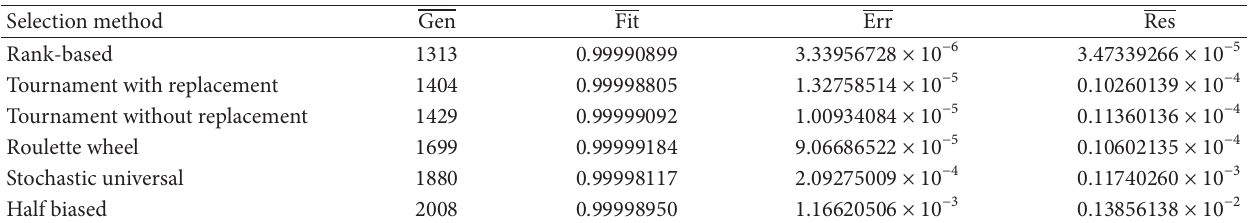
Figure 8: The effect of the population size of the algorithm for Troesch’s problem when 𝜆 = 1 on the (a) Gen, (b) Fit, (c) | Err | , and (d) | Res | . Table 13: The influence of selection schemes on the convergence speed, the average fitness, and the corresponding errors for Bratu’s problems when 𝜇 = 2